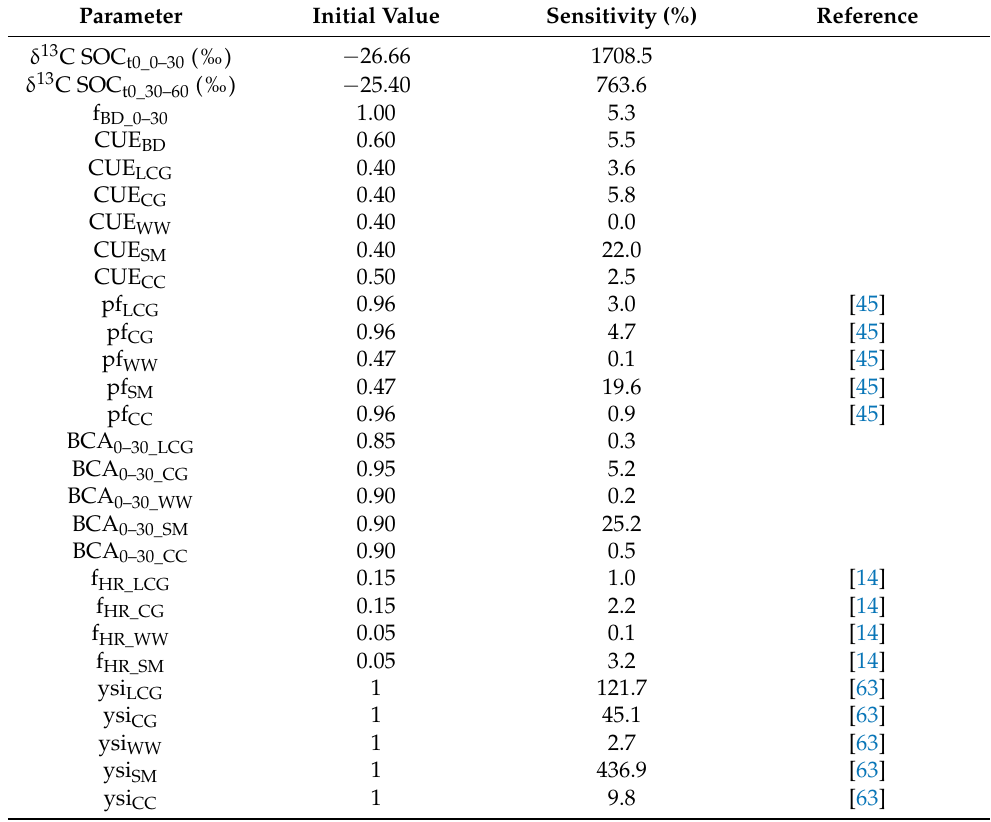
Table A3. Initial parameter values and sensitivities of model parameters used in the model. Sensitivity was quantified as being a 10% variation in the parameter values when keeping the other parameters constant and calculating the percentage change in the sum of squared errors (SSE) compared to the SSE calculated with the initial value. References are given for those parameter values that were obtained from